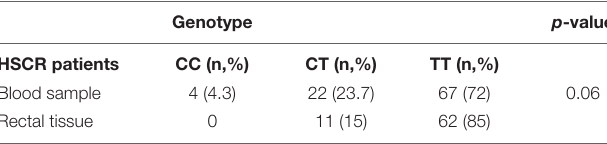
TABLE 1 | Comparison of RET rs2435357 genotype in HSCR patients between rectal and blood samples (6).